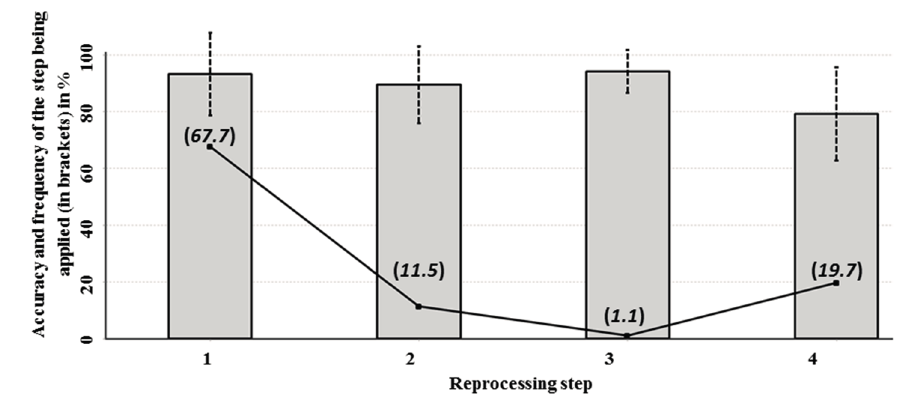
Figure 7. Accuracy of cloud interpolation steps as identified from simulating artificial clouds. Accuracy (grey columns), Standard Deviation (black dotted line bars), and frequency of a step being applied to the input data (black continuous